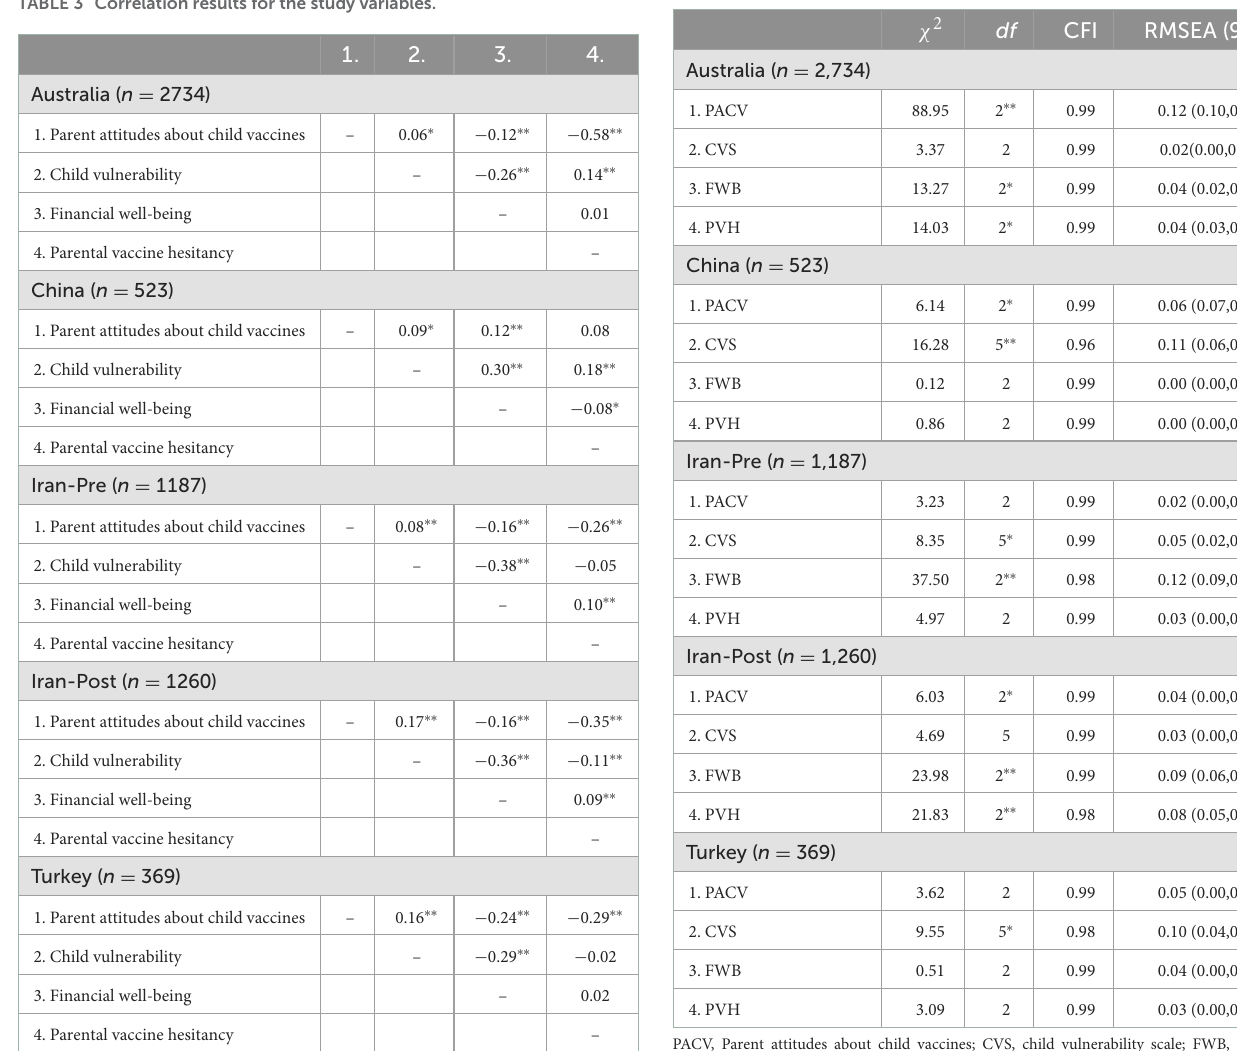
TABLE 4 Model fit statistics for the confirmatory factor